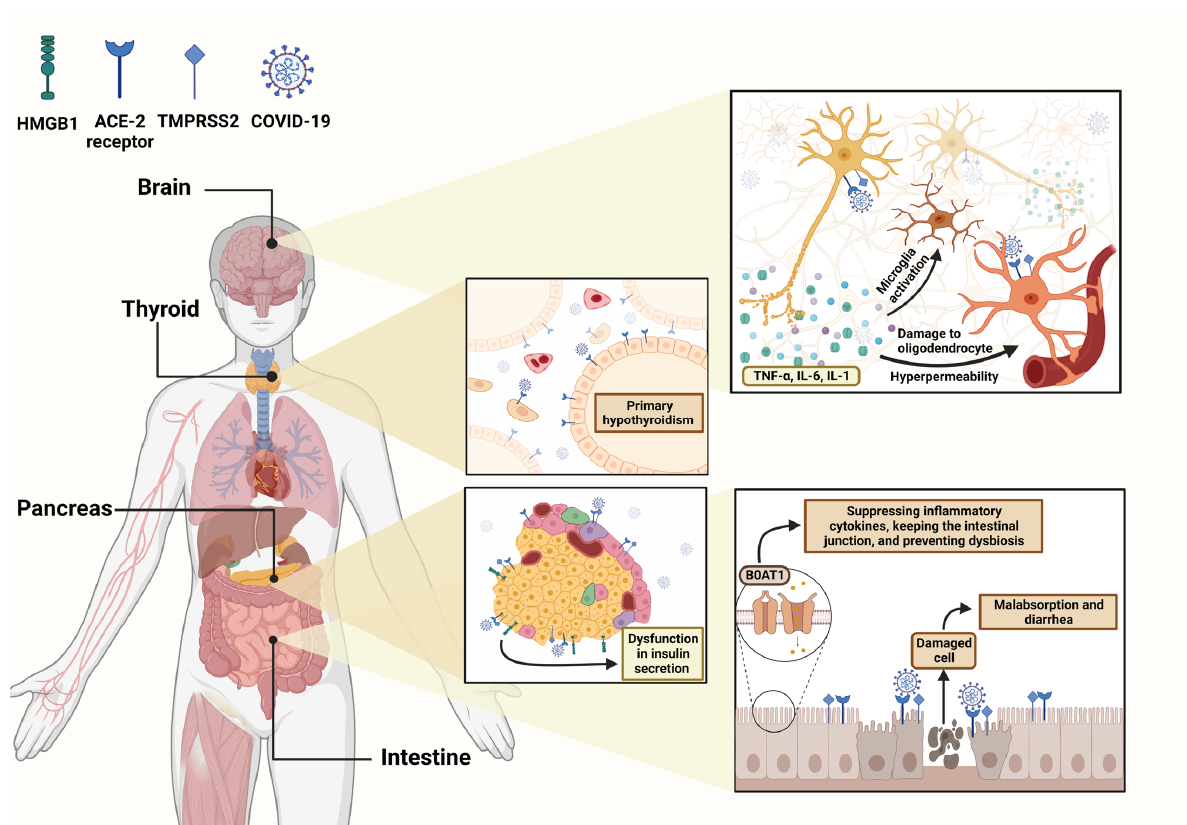
Figure 3. Overview of proposed mechanisms of COVID-19 on damage organ. Besides the respiratory system, the virus may infect and damage a wide variety of other tissues and organs. Virus infection increased the expression levels of IL-6, IL-1, and TNF-α. Even without viral invasion or dissemination, cytokine-driven damage can undermine the BBB. Neurotoxic cytokines can also activate microglia. B0AT1 modulates the absorption of tryptophan in the gut, interfering with immunity by suppressing inflammatory cytokines, maintaining the intestinal junction, and preventing dysbiosis. Also, COVID-19 can infect a follicular cell in thyroid gland and β cells in the pancreas and lead to hypothyroidism and hypoinsulinemia, respectively. (Created with BioRender.com).